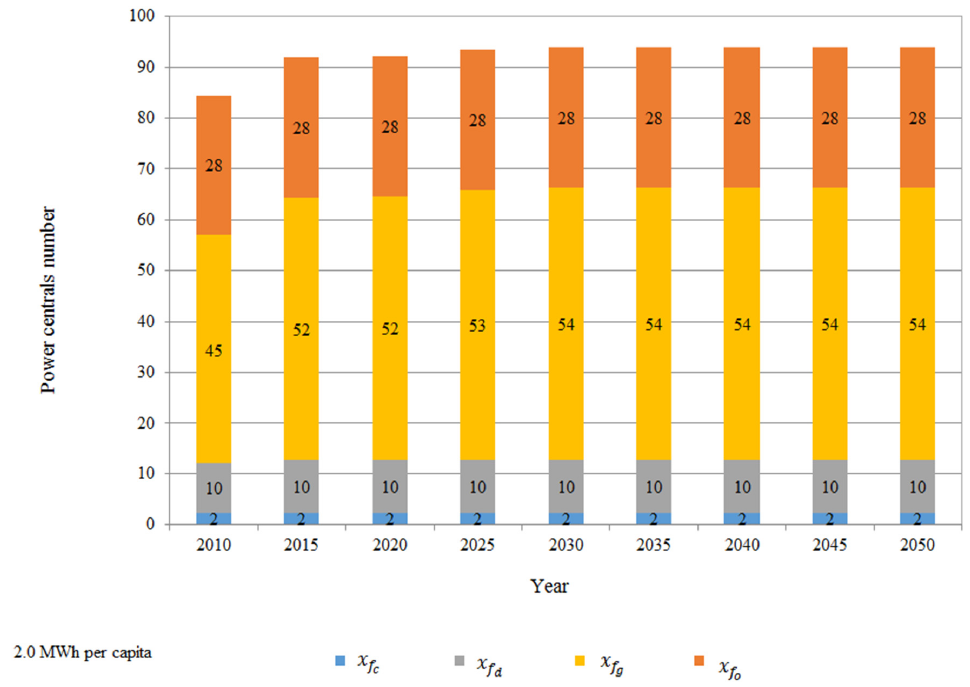
Figure 10. Optimized power plants number from fossil energy resource for 2.0 MWh per capita demand with the LVF model .